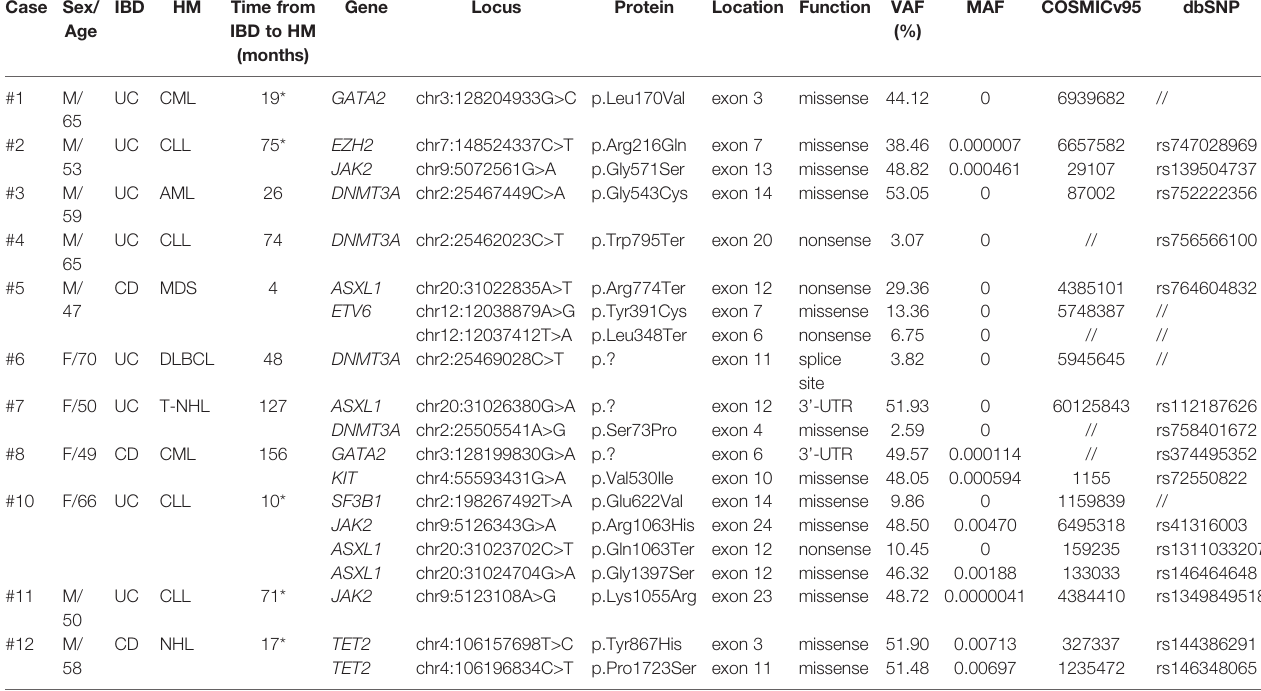
TABLE 1 | Annotation of variants identi fi ed in IBD